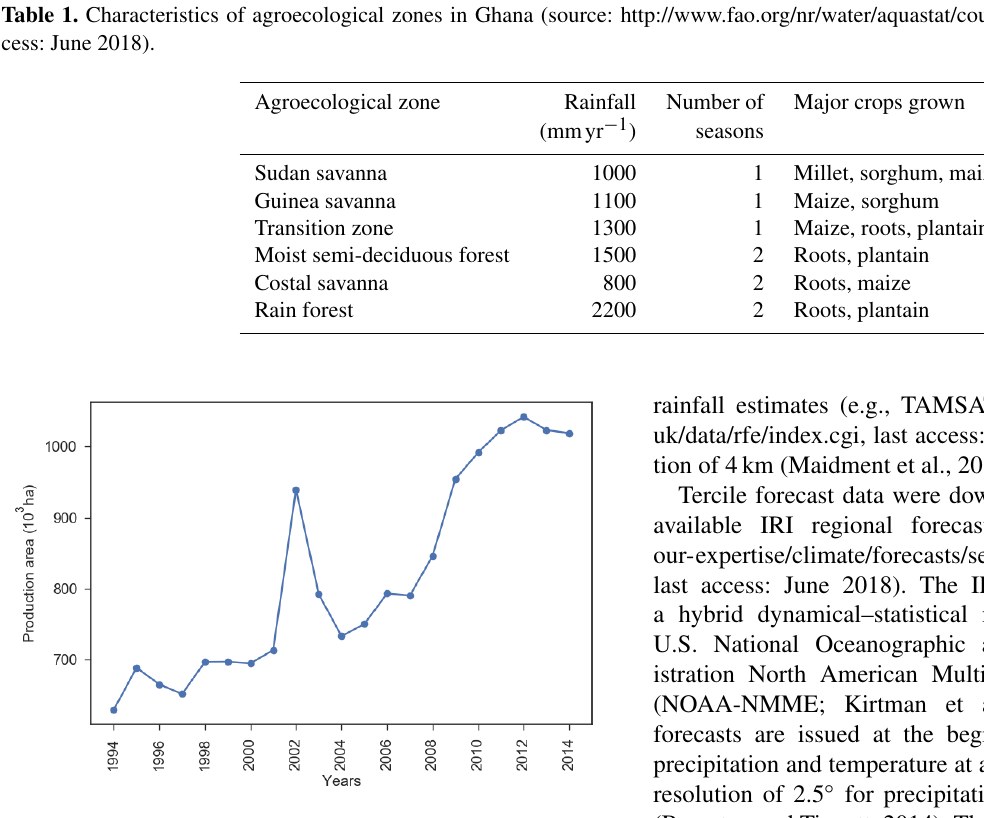
Figure 3. Maize production area over Ghana from 1994 to